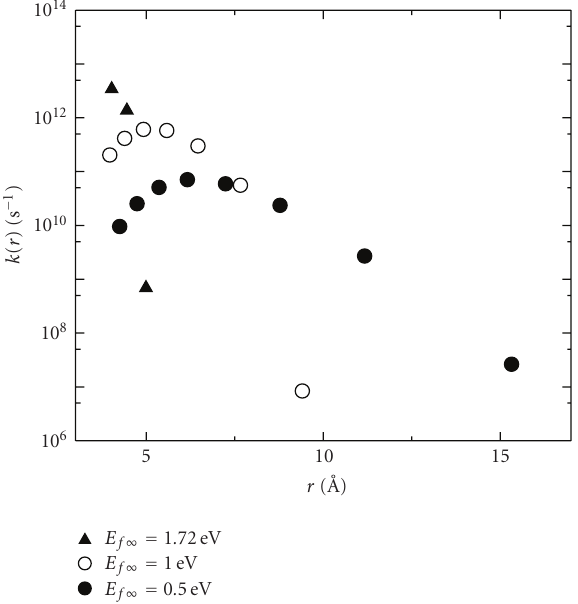
Figure 3: First-order ET rate in nonpolar solvent calculated for three values of E f ∞ with J 0 = 100 cm − 1 at 6 ˚A, β = 1 ˚ A − 1 , v = 1500 cm − 1 , and λ = 0 . 3 eV. ET occurs at discrete r